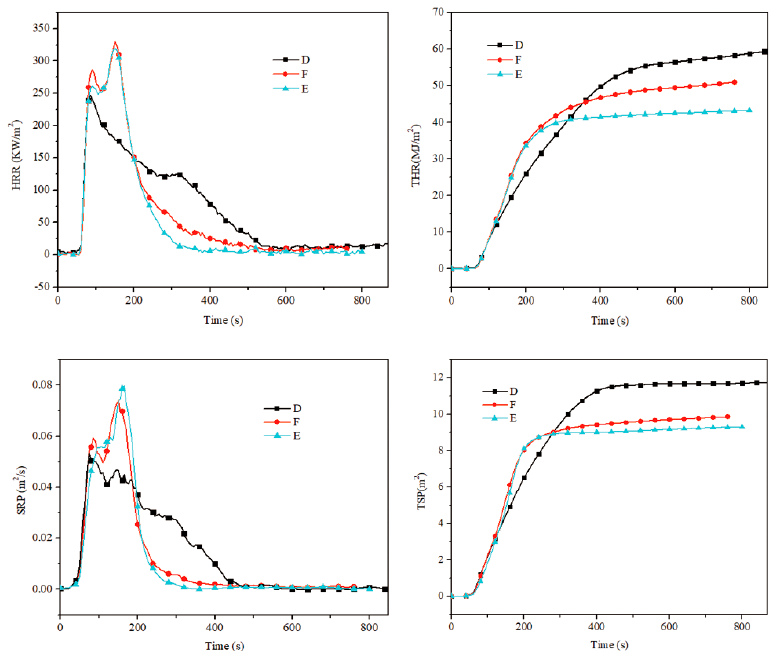
Figure 9. The CONE curve of HPN-EPPA-UR-PA resin, D: 10 wt% urea; E: 5 wt% urea; F: 0. Table 3. Data of cone calorimeter of HPN-EPPA-UR-PA resin.